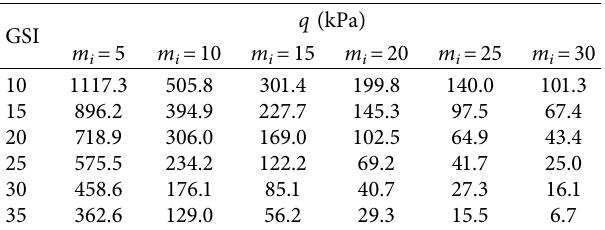
Figure 7: Effect of l and h on the surrounding rock pressure e . Table 5: Upper bound solution of the surrounding rock pressure q at different GSI and m i